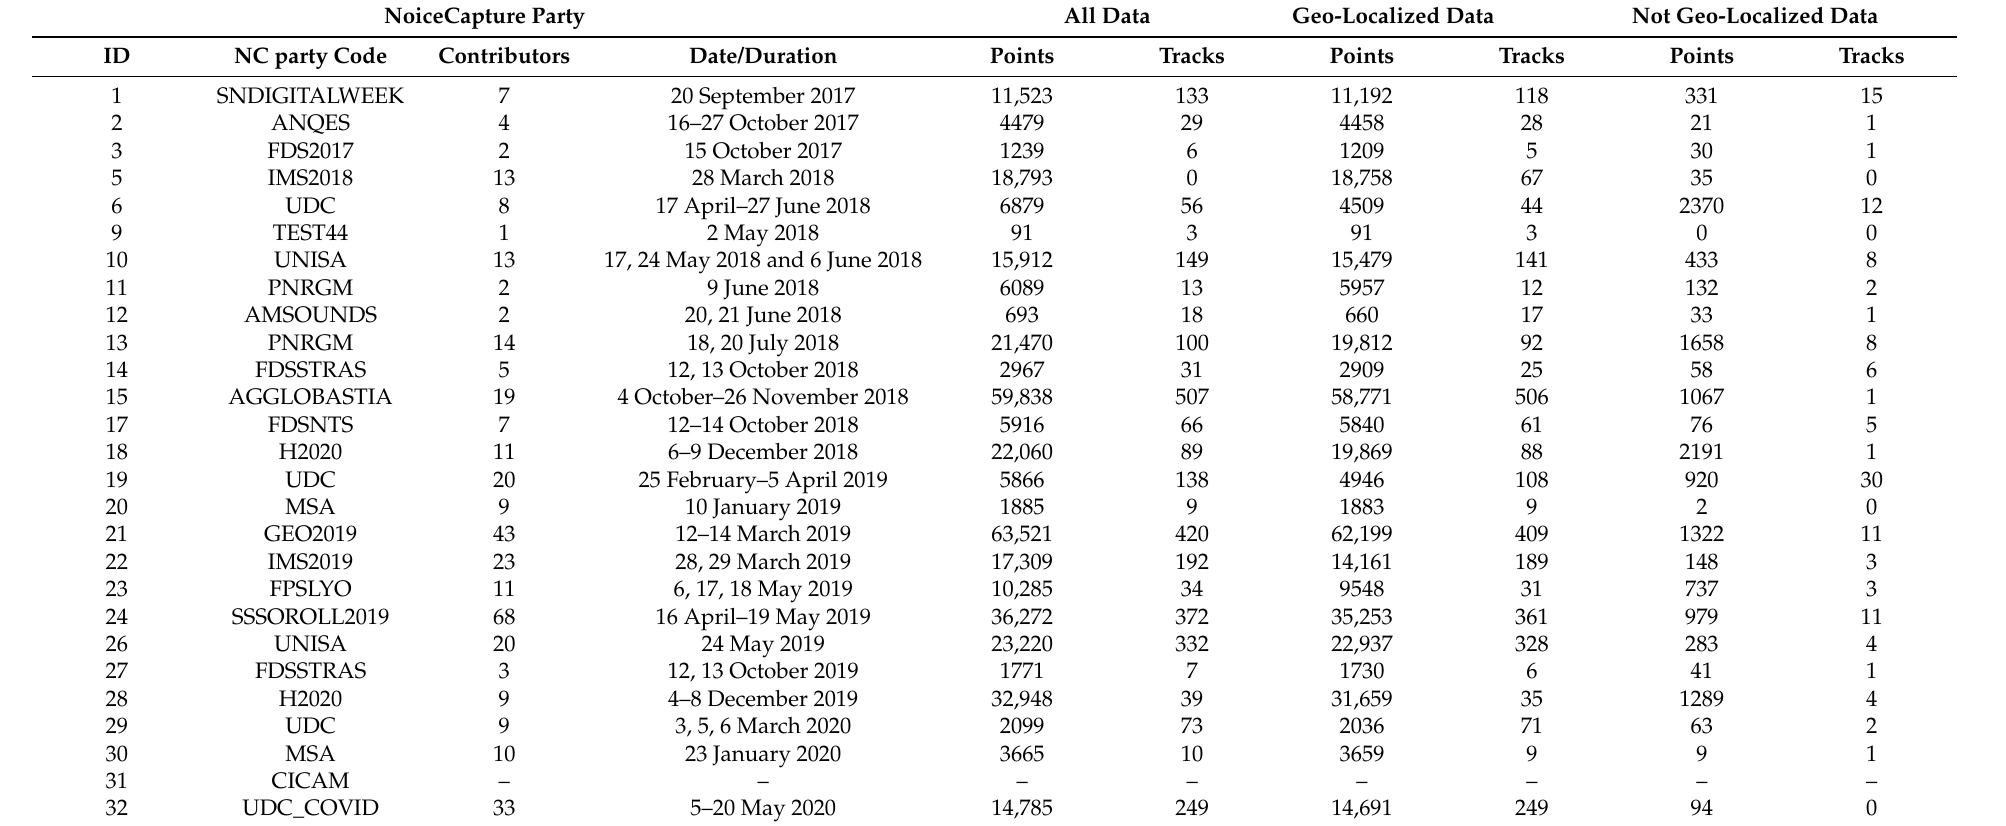
Table 1. NC parties